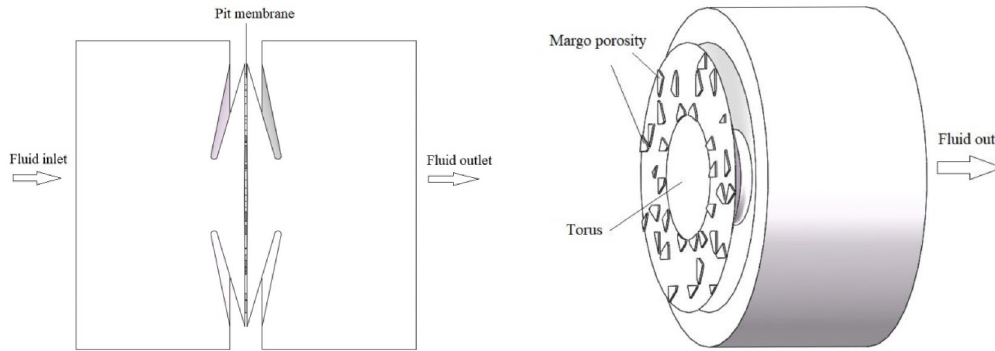
Fig 5. Fluid domain calculation model of TPS.